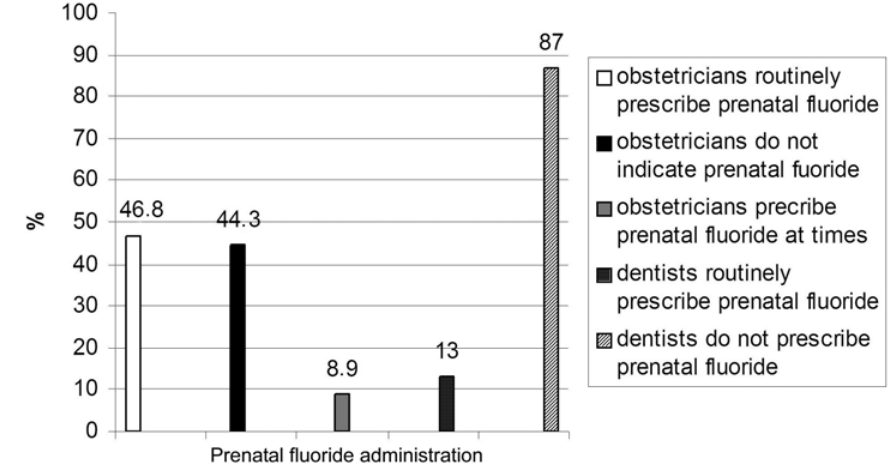
FIGURE 5- Prenatal fluoride administration practice among